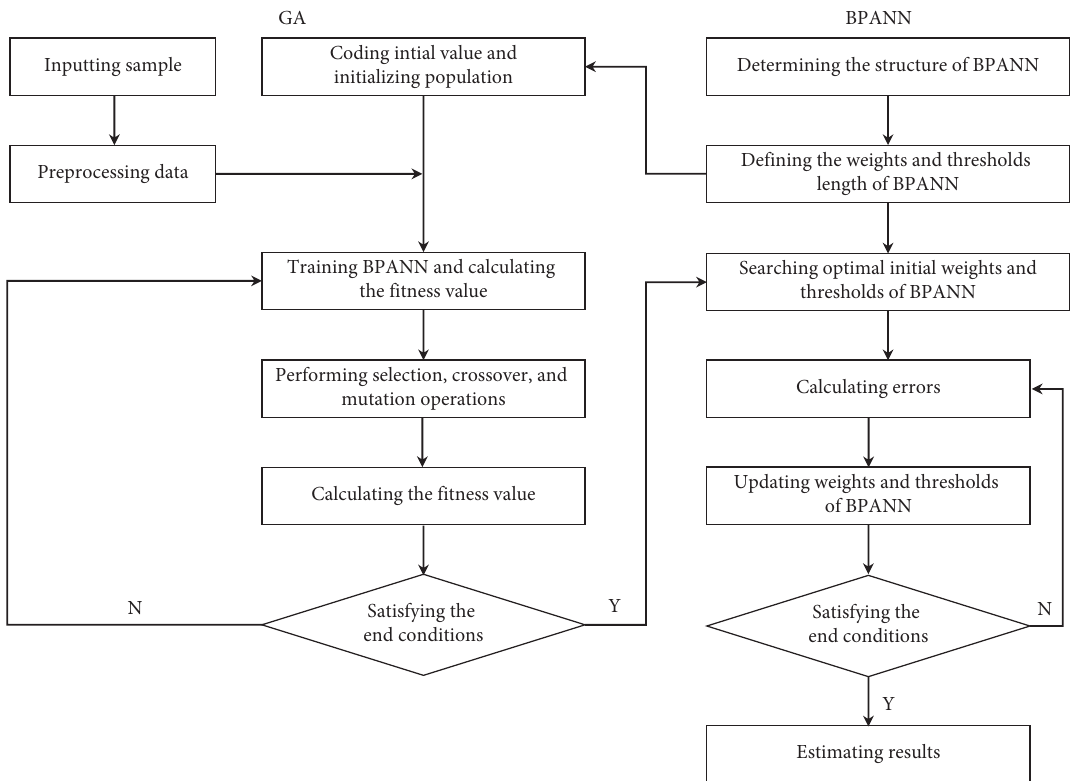
Figure 3: Flowchart of BPANN optimized with GA. The parameters in GA mainly include population size, evolutionary times, crossover probability, and mutation probability. In this study, the parameters were set as follows: population size of 100, evolutionary times of 50, crossover probability of 0.4, and mutation probability of 0.1. In this study, the GA-BPANN model was constructed with the build-in BP and GA functions in MATLAB (2016a) GA and ANN